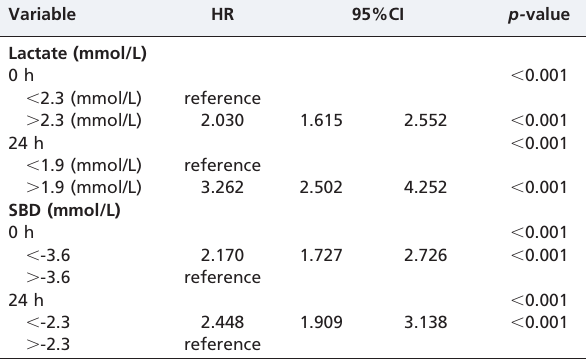
Table 3 - Univariate Cox proportional hazard analysis with hospital mortality as the dependent